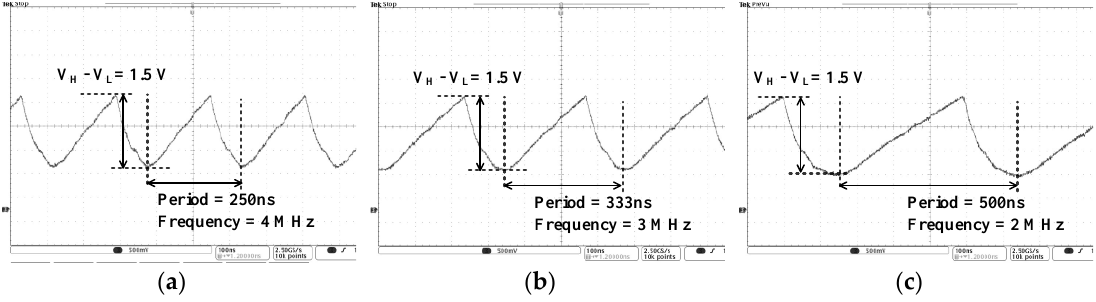
Figure 9. Measured ramp waveform: ( a ) normal load condition (I LOAD : over 100 mA), ( b ) light load condition (I LOAD : from 50 mA to 100 mA) and ( c ) very light load condition (I LOAD : under 50 mA).